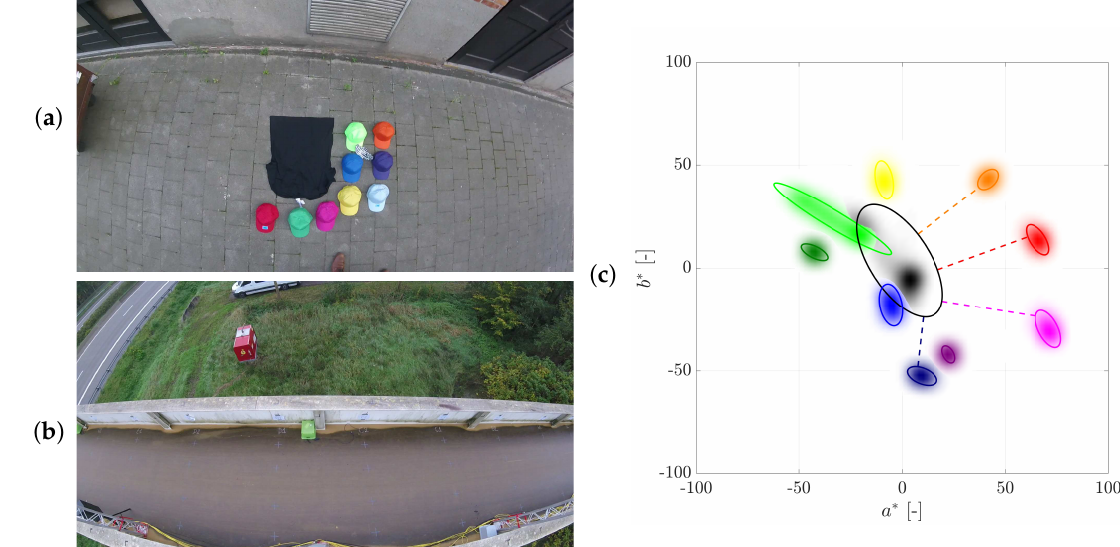
Figure 7. Results of the preliminary study to select four hat colors: ( a ) snapshot of the candidate hats ( b ) one of the many snapshots of the background and ( c ) representation of the ( a ∗ , b ∗ ) coordinates of the colored hats (corresponding colors) and the background (black) by a heat map and 95% confidence regions (lines) and indication of the minimal distance between the 95% confidence regions of the selected hat colors to the background (dashed